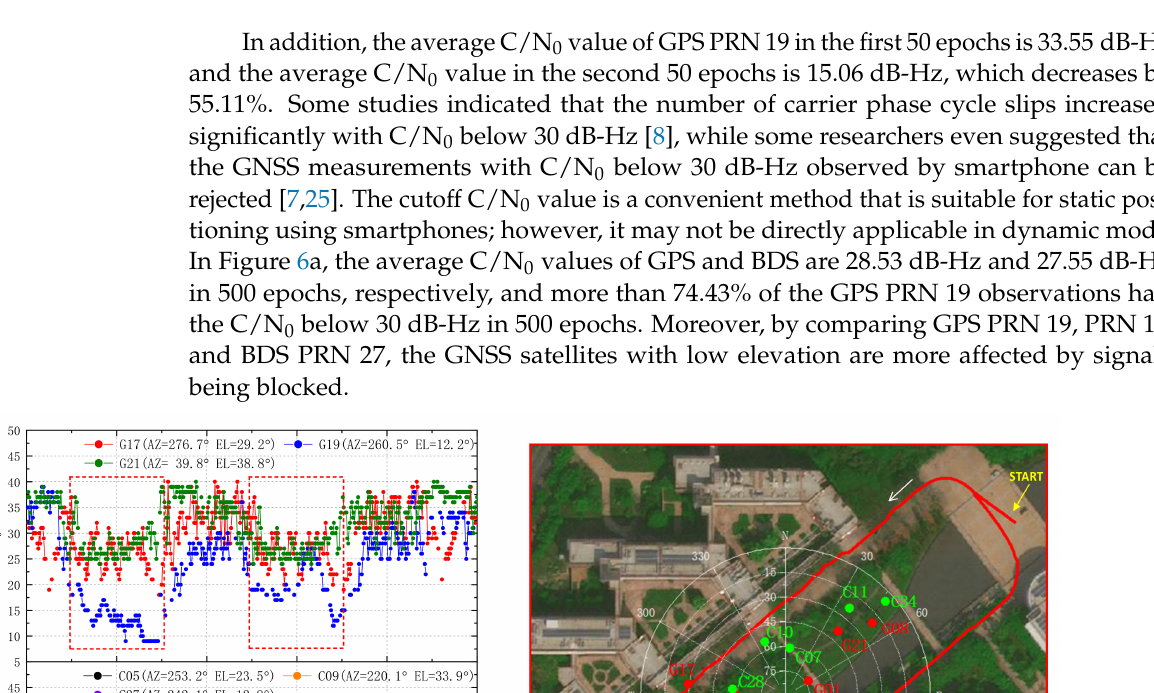
Figure 5. Number of GNSS satellites and PDOP values on the sidewalk in area 2. ( a ) GPS and BDS measurements observed by Mate 30; ( b ) GPS measurements observed by the geodetic receiver and Mate 10.